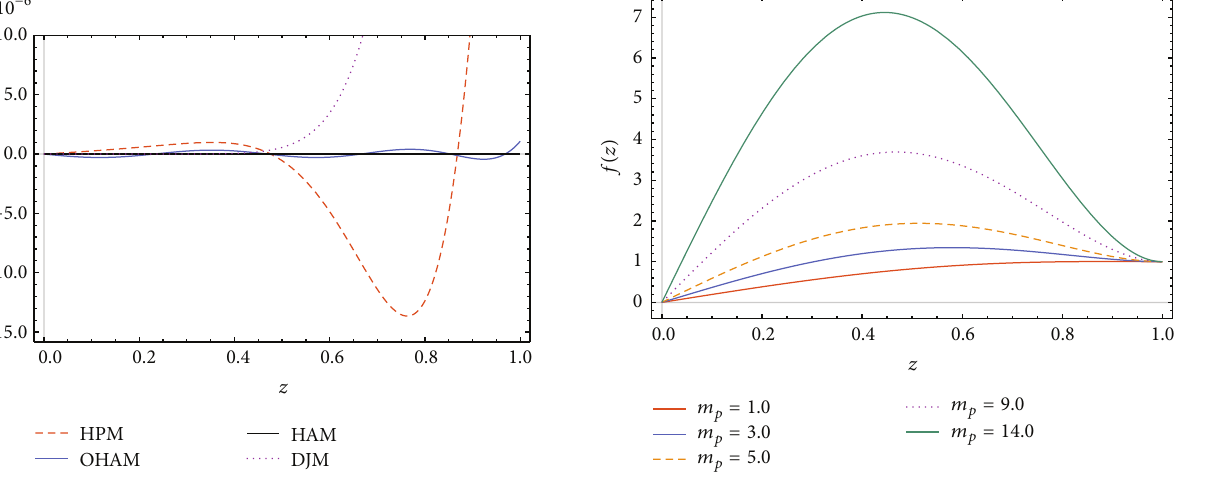
Figure 5: Comparison of HAM with other analytical schemes through residual.